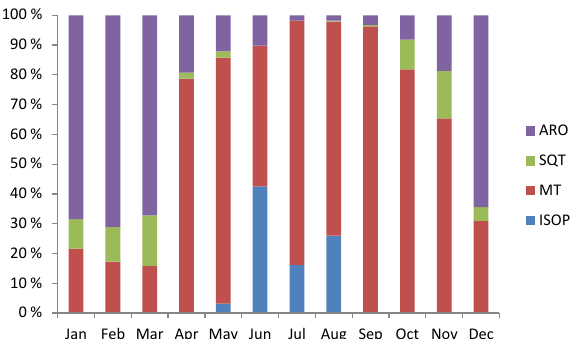
Fig. 12. Relative contribution of different BVOC groups to the OH reactivity. Sesquiterpene contribution is missing in June and July due to chromatographic problems.